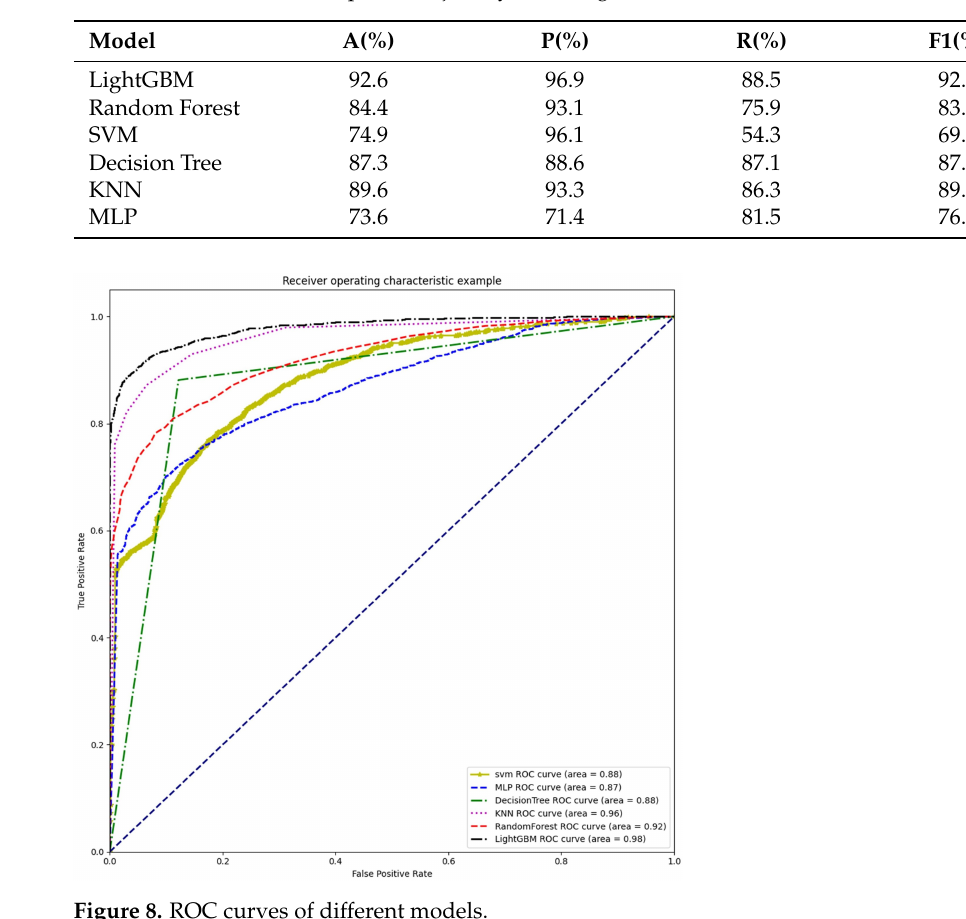
Table 8. Evaluation of face–phone trajectory matching determinators.